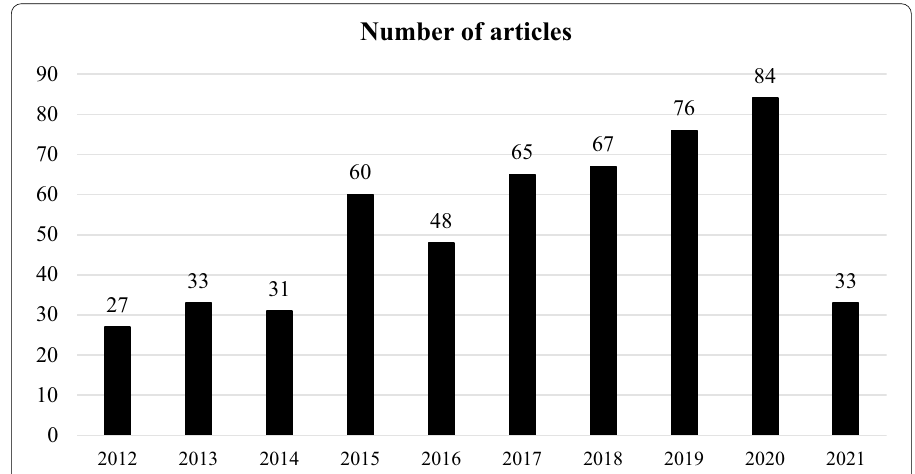
Fig. 2 Publication trend of 524 published articles, indexed to WoS, between 1:2012 and